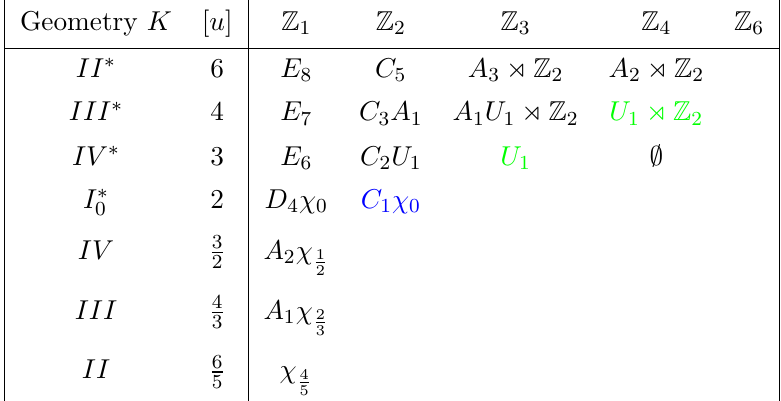
= 2 rank 1 SCFTs N